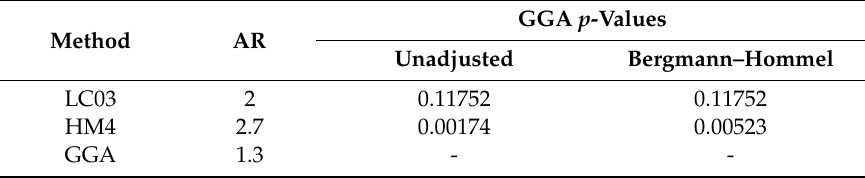
Table 9. p -values for multiple comparisons among methods.